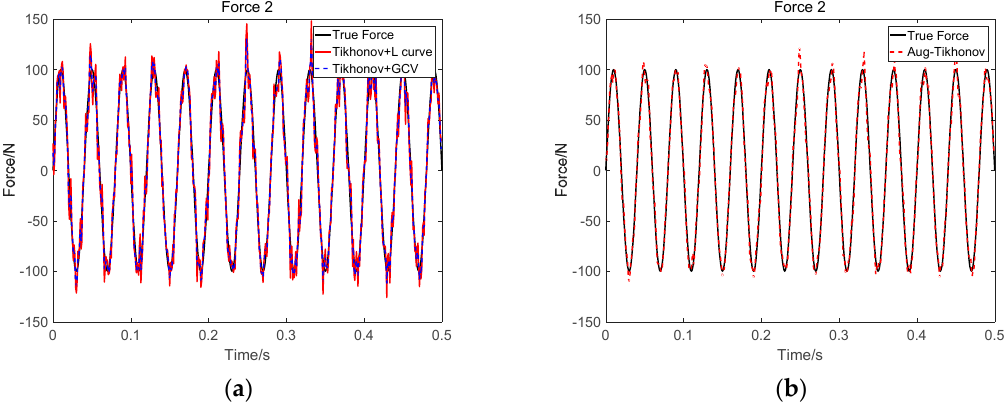
Figure 15. Identification result of two sinusoidal loads at SNR 40 dB (Force 2): ( a ) Tikhonov method;